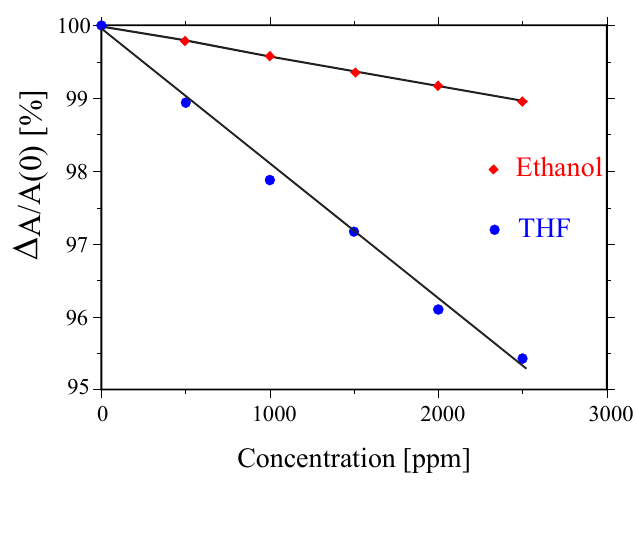
Figure 7. Optical response of CLCs embedded in imprinted polymer for THF and EtOH showing enhanced selectivity for imprinted THF than